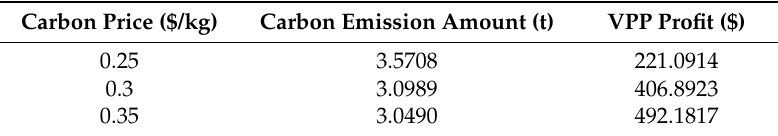
Table 2. Carbon emission amount and VPP profits under three different carbon